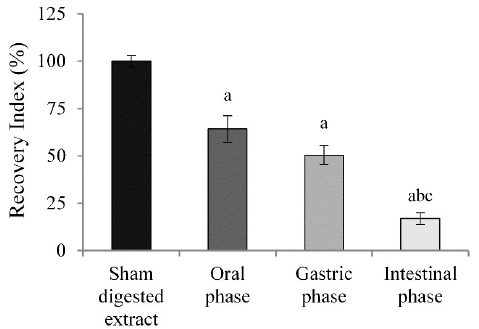
Figure 1. Recovery Index (RI) of anthocyanins. The total ACN content (TAC) in sham-digested and BBE digested extracts (all diluted in parallel to 8 mL) was analyzed by the pH differential method, expressed as C3G equivalents, and finally, RI was calculated. The sham-digested extract was used as reference for the RI calculation. Results are expressed as mean ± SD calculated from three independent experiments. a p <0.05 vs. sham-digested; b p <0.05 vs. oral phase c p < 0.05 vs. gastric phase.